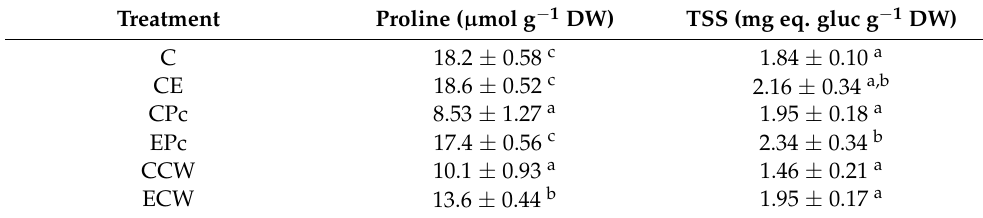
Table 5. Effect of soil treatments on osmolyte contents. Pro: proline, TSS: total soluble sugars; gluc: glucose, used as the standard in TSS determination. Treatments: Soil sampled in the Chinampas area was used as control (C); soil contaminated with endosulfan (CE); control soil bioremediated with Penicillium crustosum (CPc); endosulfan-contaminated soil, bioremediated with P. crustosum (EPc); control soil bioremediated with citric waste (CCW); endosulfan-contaminated soil, bioremediated with citric waste (ECW). Values represent the means of five replicas (five individual plants) followed by SD. Different letters in each column indicate significant differences between treatments, according to the Tukey test at the 99% confidence level.